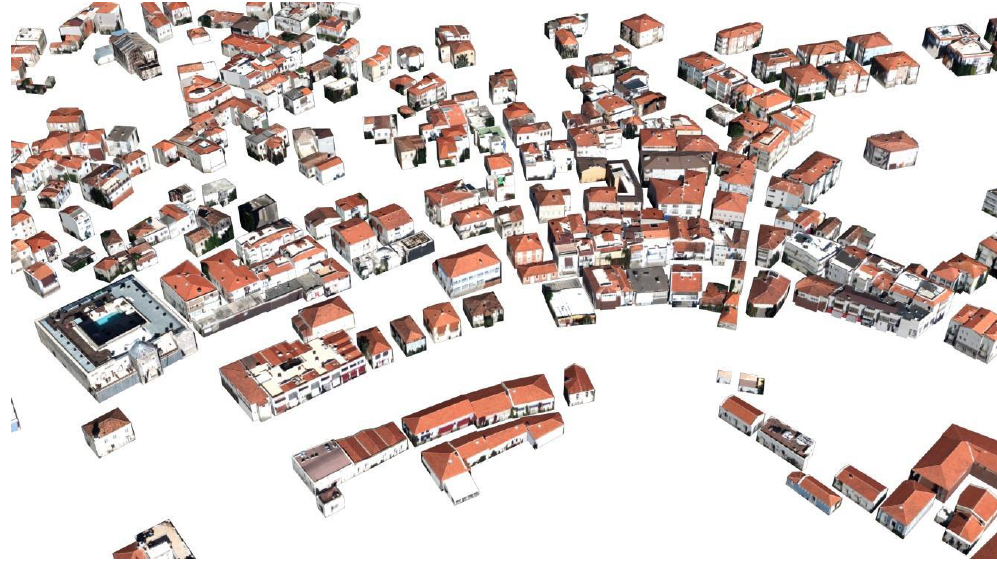
Figure 18. Exported CityGML buildings with textures.